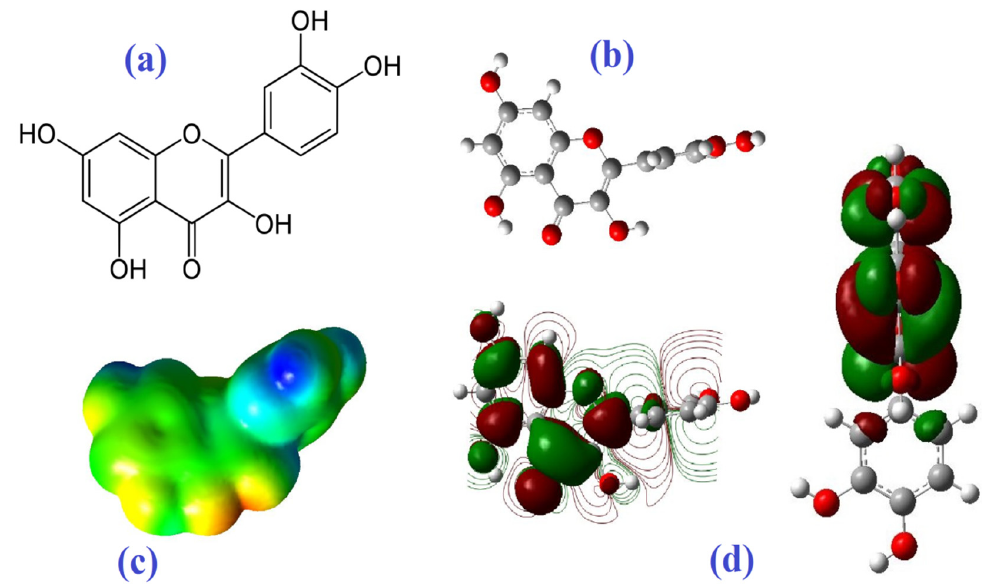
Figure 9. The molecular structure ( a , b ), total electron density maps ( c ), 3D model of HOMO-LUMO molecular orbitals, and ( d ) contour plots (side view: left ; front view: right ) of quercetin.